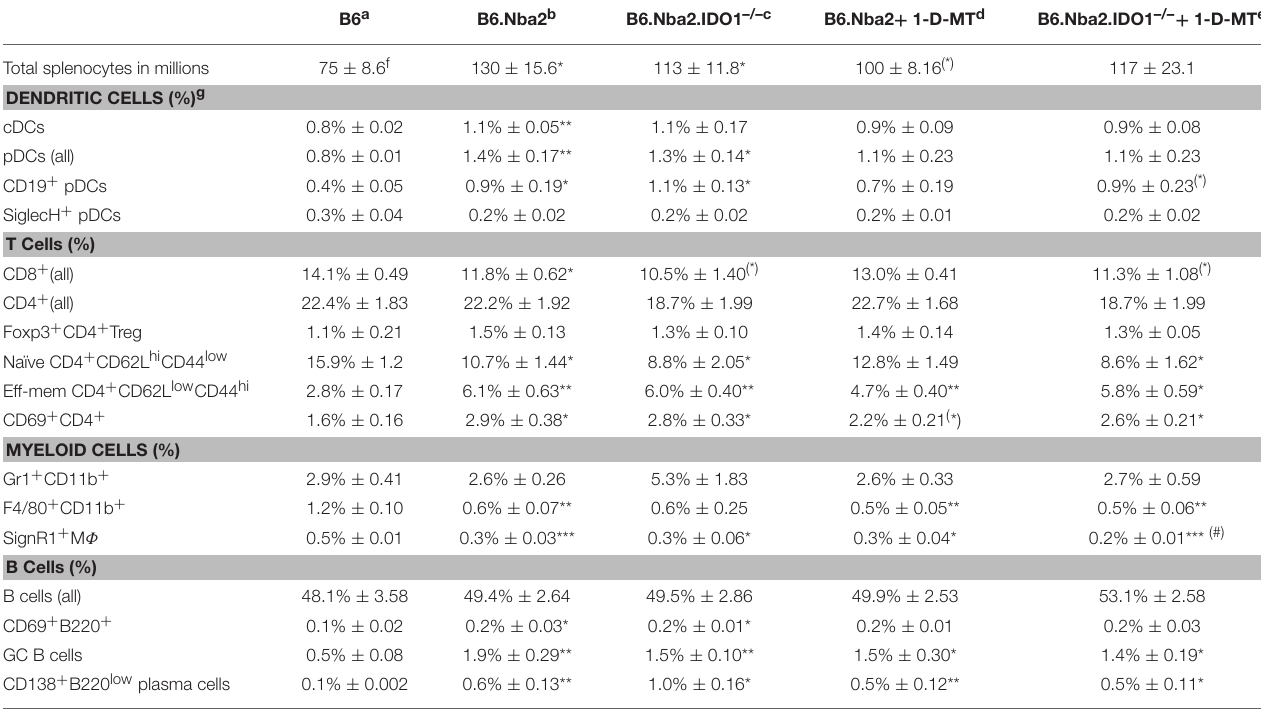
TABLE 1 | Splenic cellular composition in 12 week old B6, B6.Nba2, and IDO-manipulated B6.Nba2